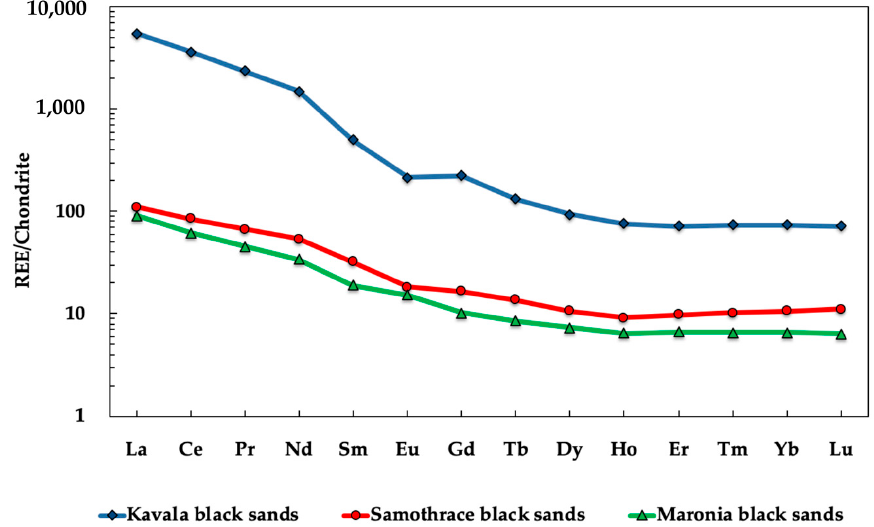
Figure 6. Chondrite-normalized REE patterns of coastal sands from N. Greece (Kavala, Maronia, and Samothrace).